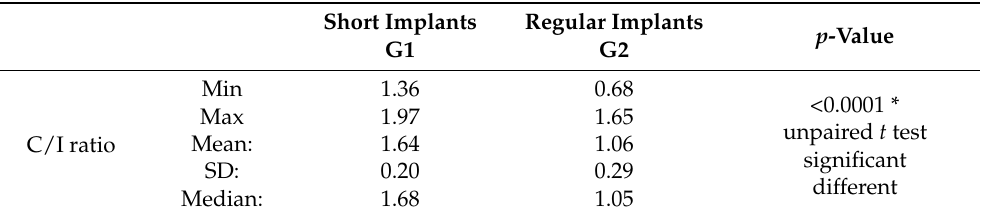
Table 3. Crown-to-implant ratio ( C / I ratio), * significant different.